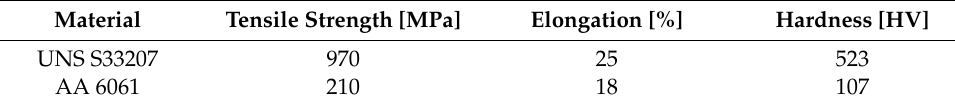
Table 1. Mechanical properties of UNS S33207 and AA 6061.